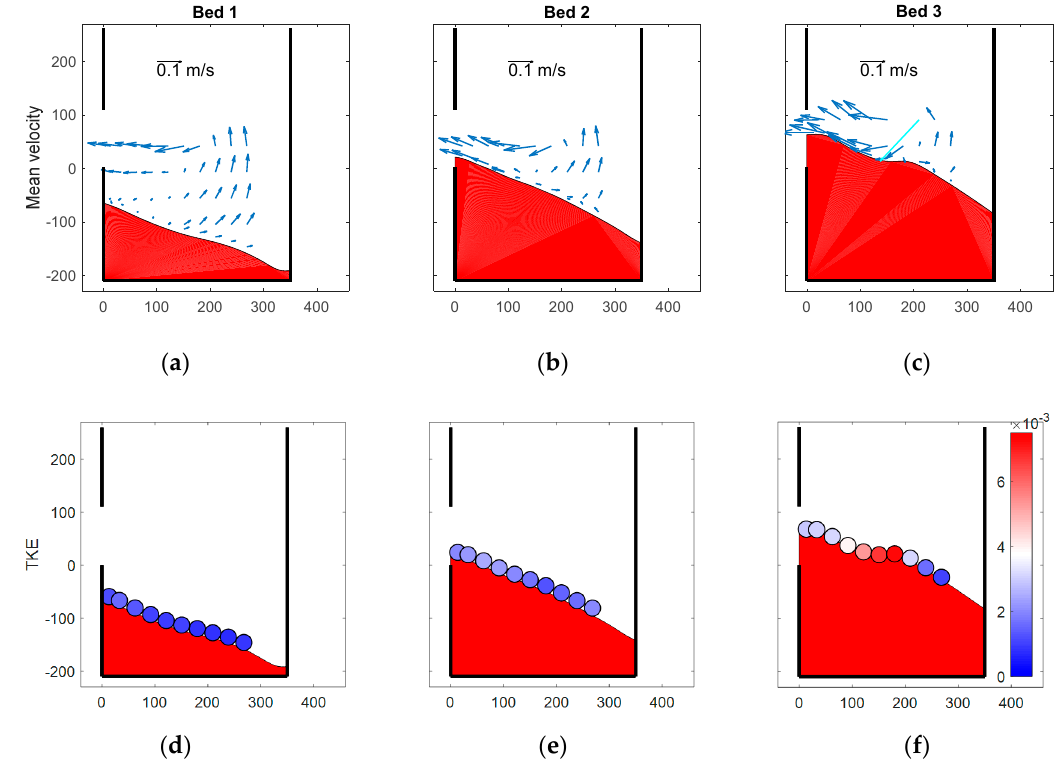
Figure 13. The effect of a growing sediment bed on ( a – c ) the mean velocity, and ( d – f ) the turbulent kinetic energy (TKE) (of which the latter is measured at 7 mm from to the sediment bed).